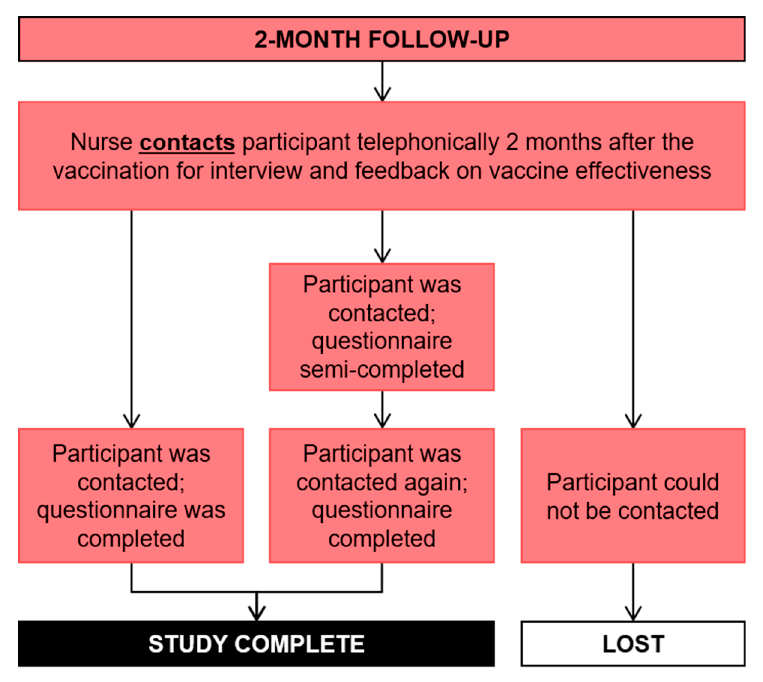
Figure 9. Two-month follow-up.